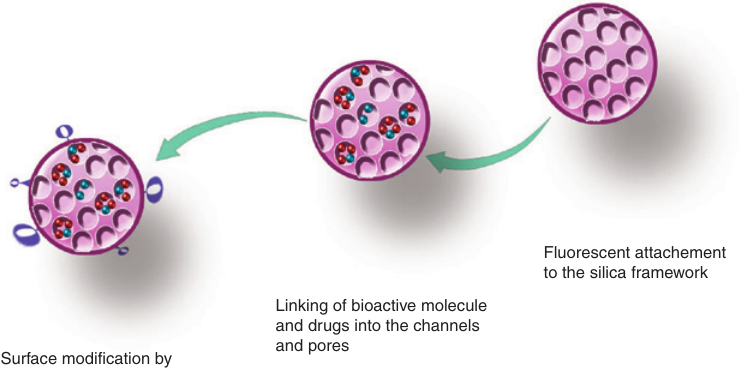
Figure 1: Basic structure of